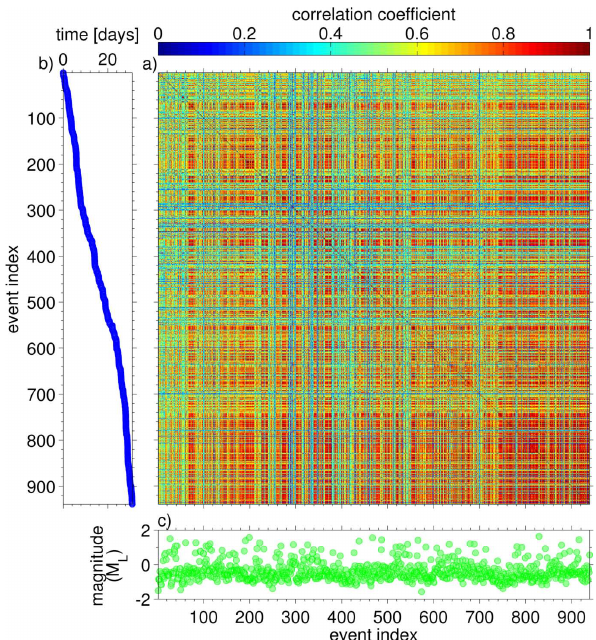
Fig. 2. Chronologically ordered similarity matrix for event data of October 2006 and station HM10 (a) . (b) and (c) provide additional information on the time of occurrence and the magnitude distribu- tion,